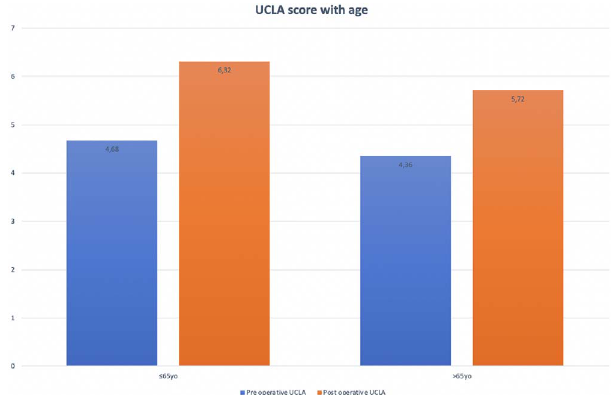
Figure 3. Pre- and post-operative UCLA score with